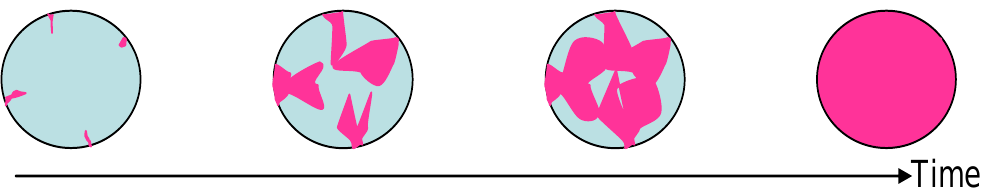
Figure 27. Bulk Diffusion Controlled Conversion in Entrained Flow Gasifiers.